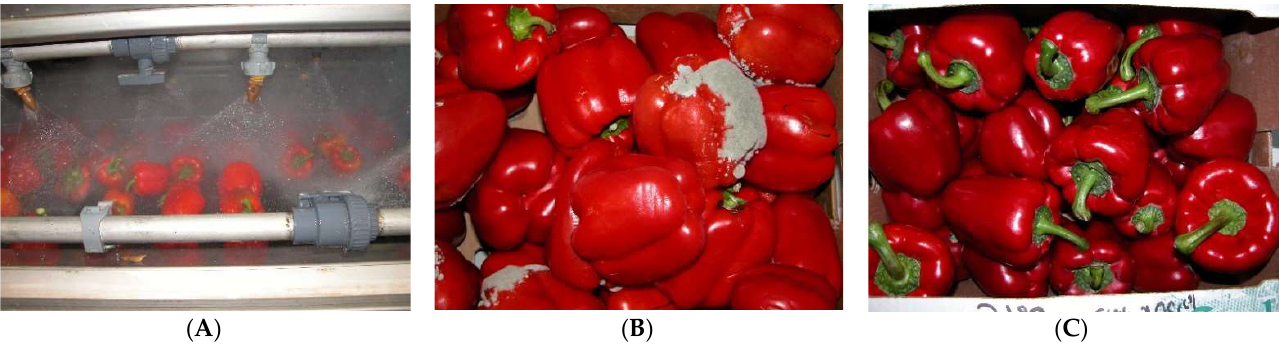
Figure 1. Postharvest processing and gray mold development in red peppers; ( A ) hot water (55 °C) rinse and brush of peppers; ( B ) gray mold after 3 weeks of storage (7 °C) without hot water treatment; ( C ) with hot water treatment.